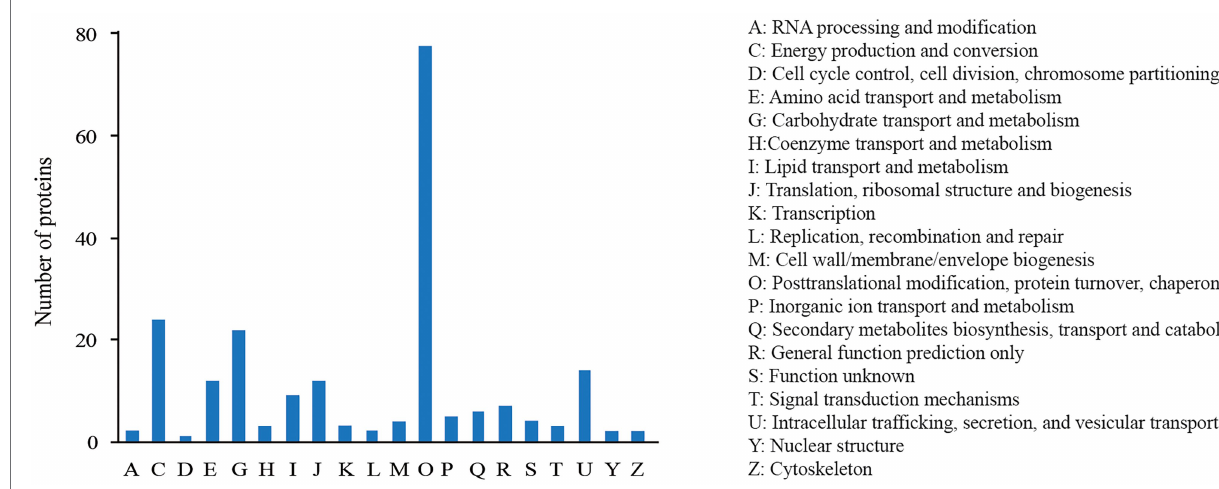
FIGURE 3 | COG annotation analysis of DEPs.